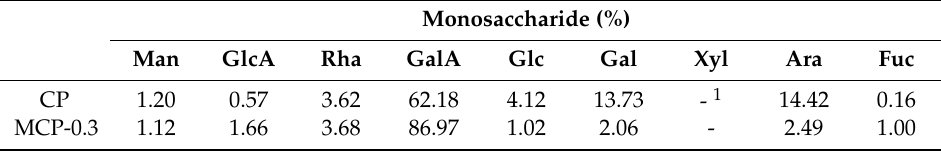
Figure 8. Elution profile of the degradation product of citrus pectin (CP) by DEAE sepharose fastflow column. The sugar content and uronic acid content were determined at 490 nm and 525 nm, respectively. Table 3. Monosaccharide composition of CP and its degradation product